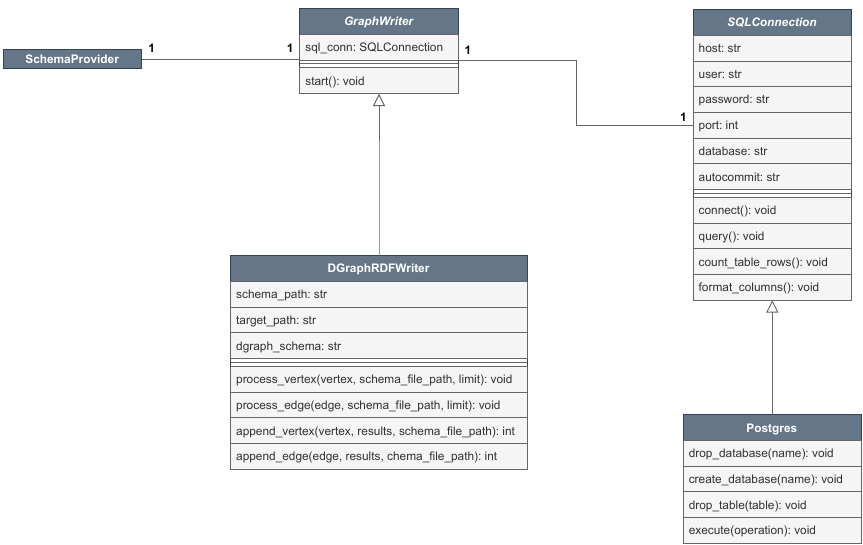
Figure 3. UML Diagram representing the migration between Postgres and